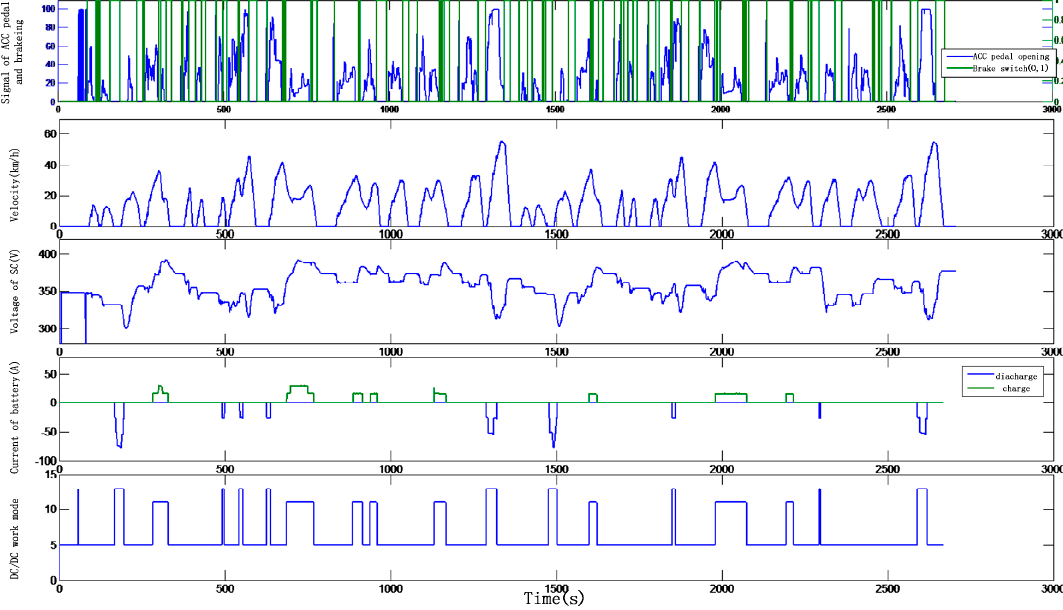
Figure 23. The process curves of PTHEB with SC/battery HESS.